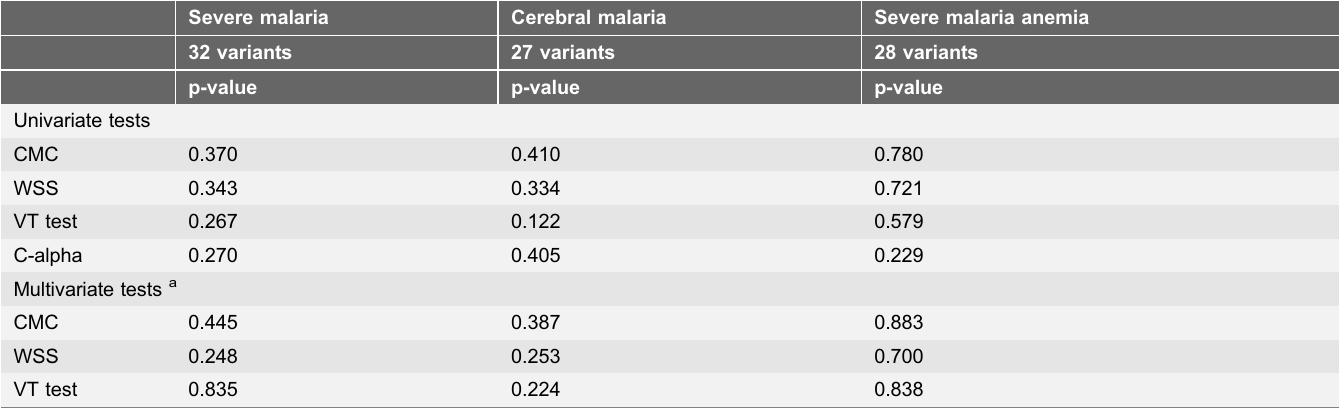
Table 4. PROCR rare variant analyses including SNPs with MAF #